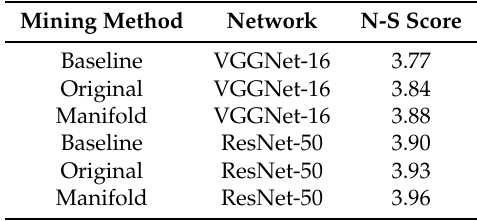
Table 2. Performance comparison of different training pairs selection methods on UKBench. Baseline refers to performance without fine-tuning. “Original” denotes the training pairs selection method based on the original similarity relationship. “Manifold” represents the method based on refined similarity with the manifold relationship. Retrieval accuracy is measured by N-S